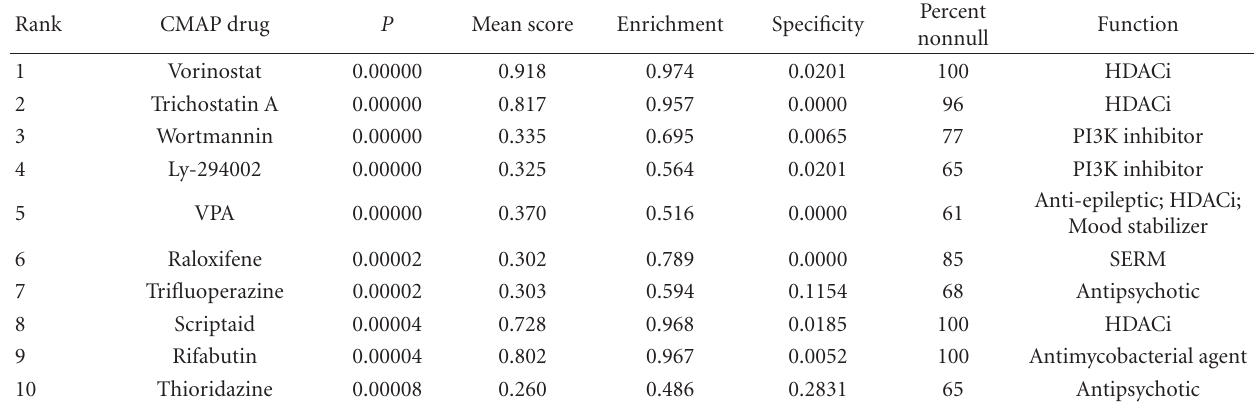
Table 3: Top CMAP hits correlated with gene expression signature induced by VPA.